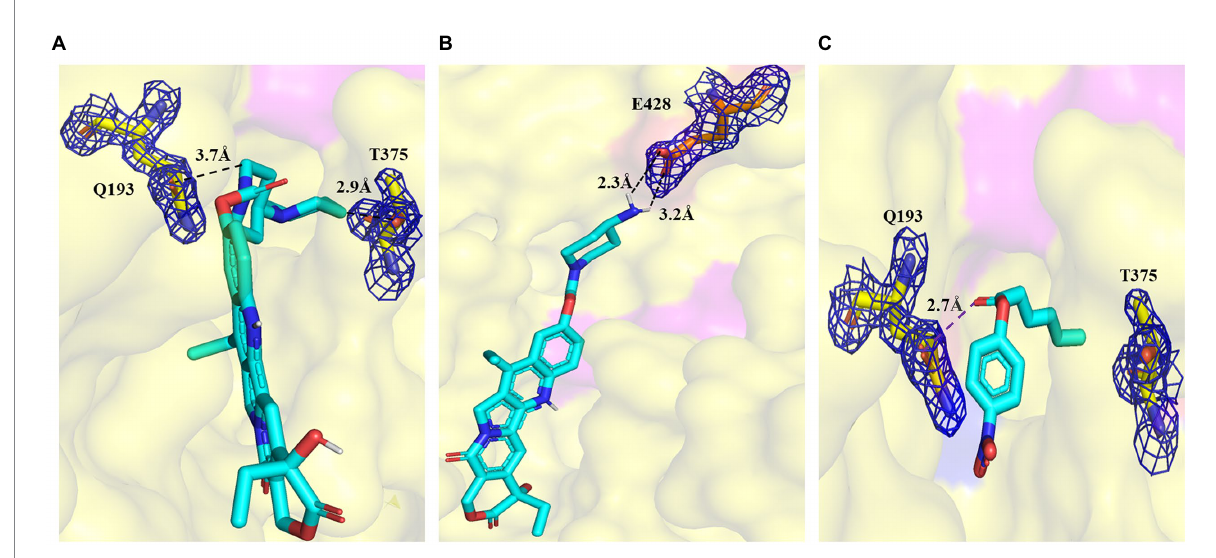
FIGURE 6 Details of the binding of CPT11 and C6 in Region B, and NPC in Region C. (A) Interaction of Q193 and T375 with the 4PP group of CPT11 in Region B. The dashed lines illustrate hydrogen bonds. (B) Interaction of E428 with the acyl groups of NPC within Region C. Dashed lines illustrate hydrogen bonds. (C) The relative locations of p -NP hexanoate (C6), Q193, and T375 in Region B. The dashed lines illustrate interaction. The electronic density map is contoured to 1.0 σ at the 2Fo-Fc